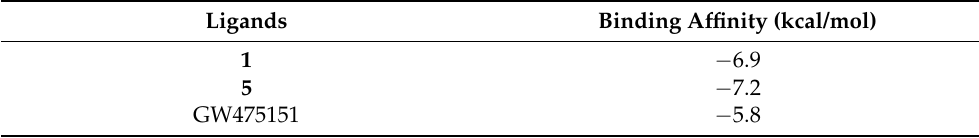
Table 4. In silico computing binding energies of compounds 1 , 5 , and